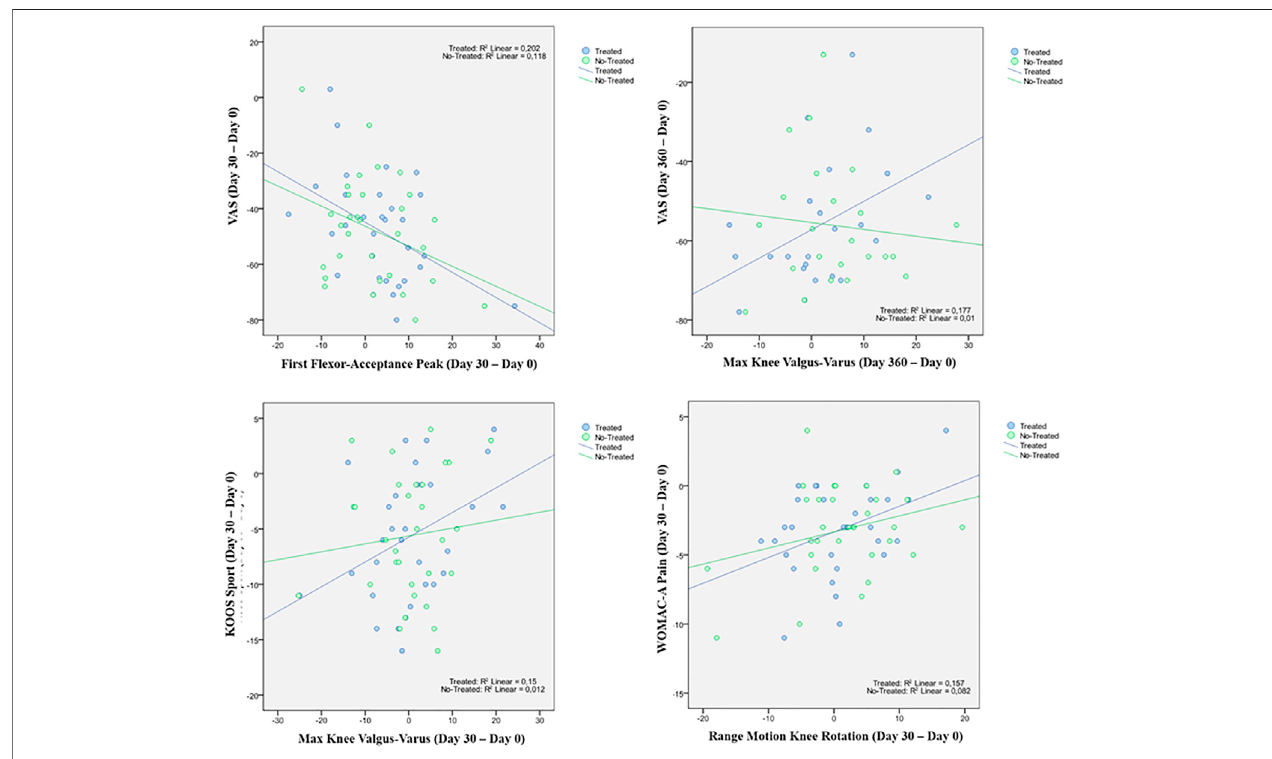
FIGURE 6 | Linear Regression